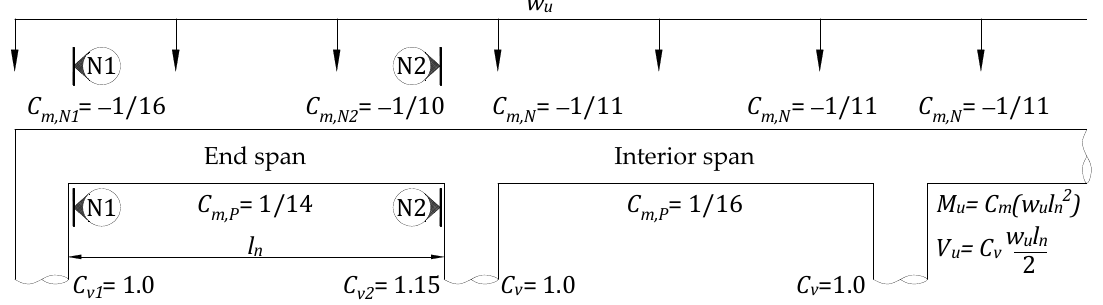
Figure 2. Moment and shear coefficients for continuous RC slabs with column supports reported by ACI 318M.